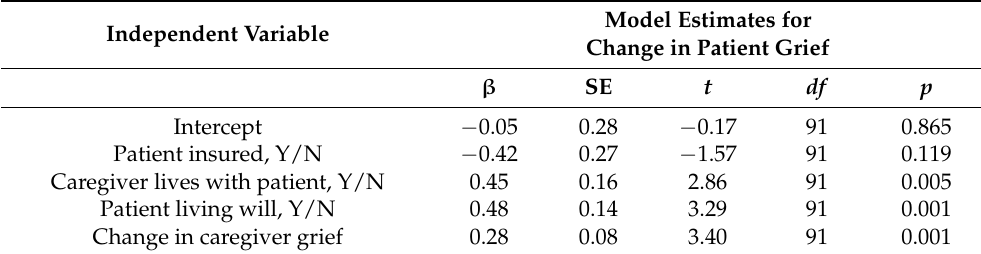
Table 2. Results for multiple linear regression model for temporal change in patient grief ( n = 96). Independent Variable